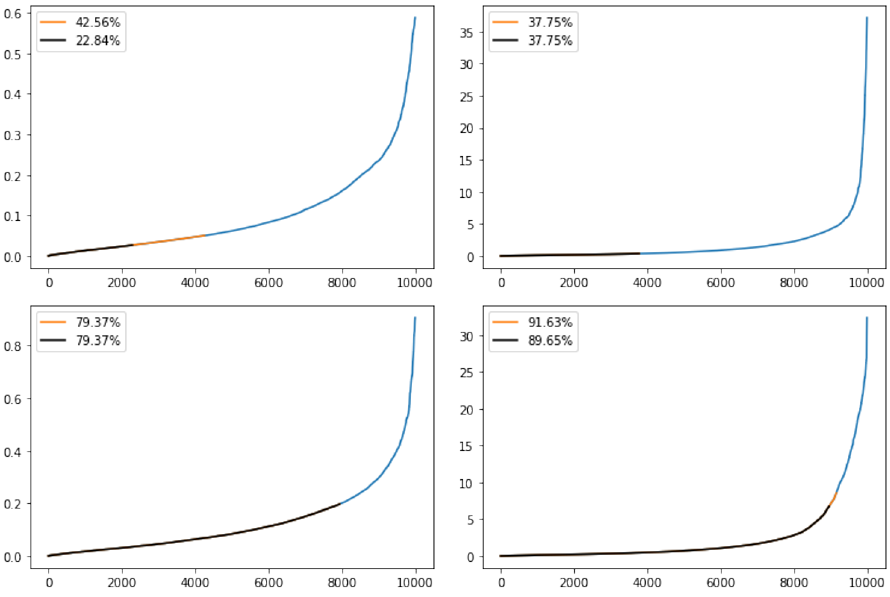
Figure 5 . From top to bottom, left to right, we have plotted the sorted 10,000 random losses for each seven functionals: L